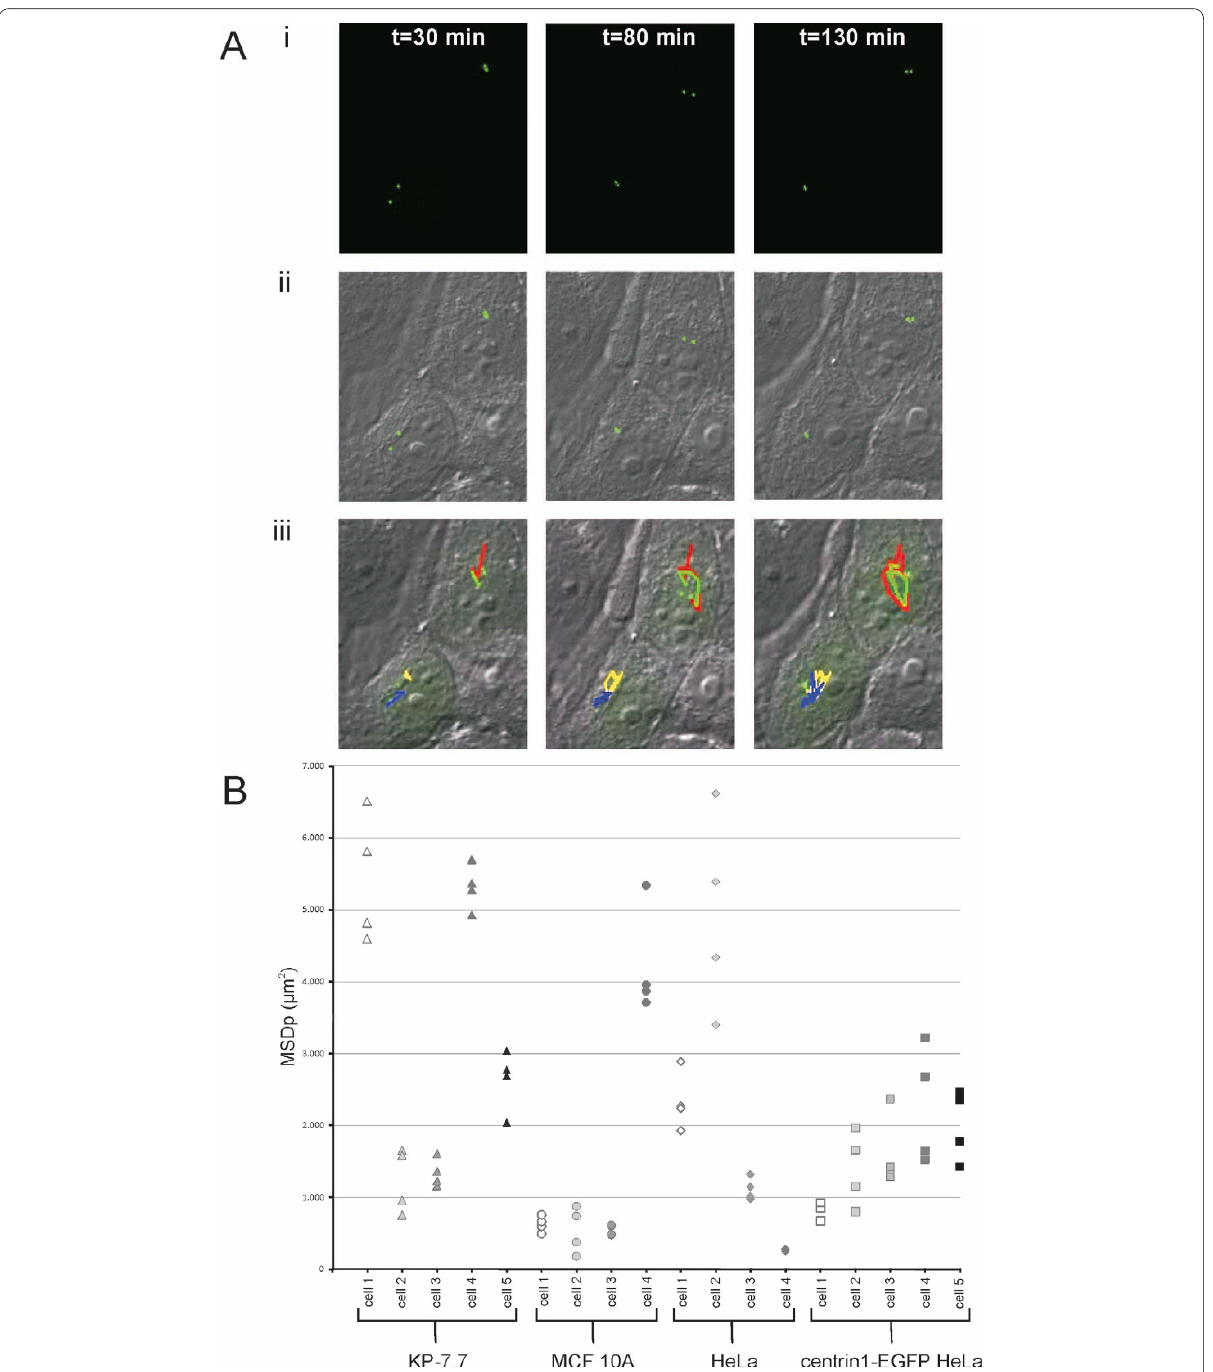
Figure 1 Tracking centrioles during cytokinesis . A) Representative images of centriole tracks in live MCF 10A cells are shown at three different time points as obtained with the tracking software Stacks (see Additional file 1 movie 1). i) The images show centriole (green) positioning at three different time points, 30 min, 80 min and 130 min after the onset of telophase. ii) The images are an overlay of centrin1-EGFP (green) and DIC. iii) The images are an overlay of centrin1-EGFP (green), DIC and the tracks of the centrioles for 130 min, from the onset of telophase. Every centriole track is represent- ed by a unique pseudo-color and the tracks are determined by linking the centrioles between time-points. Analysis of the tracks revealed that these centrioles moved as fast as 0.35 μm/min on average (see Table 1). B) Distribution of the mean square displacement (MSDp) of movements of all 4 centrioles in individual cells (therefore 4 values for every cell) of all cell lines. Different gray tones are used to separate individual cells within a cell line. Triangles represent KP-7.7, circles MCF 10A, diamonds HeLa and squares centrin1-EGFP HeLa. The tracks presented in A) is MCF 10A cell 4. Mobility varied greatly between cells within every cell line. KP-7.7 had the most mobile centrioles (Table 1). MSDp of centrioles was compared using linear mixed model, taking cells as random